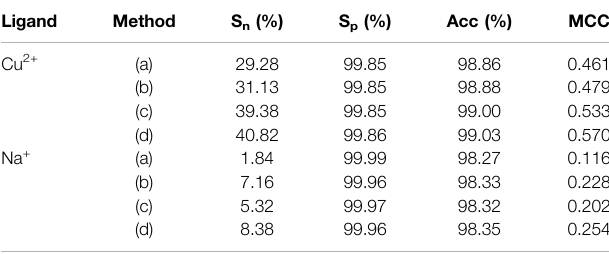
TABLE 6 | The results of 5-fold cross-validation. Ligand